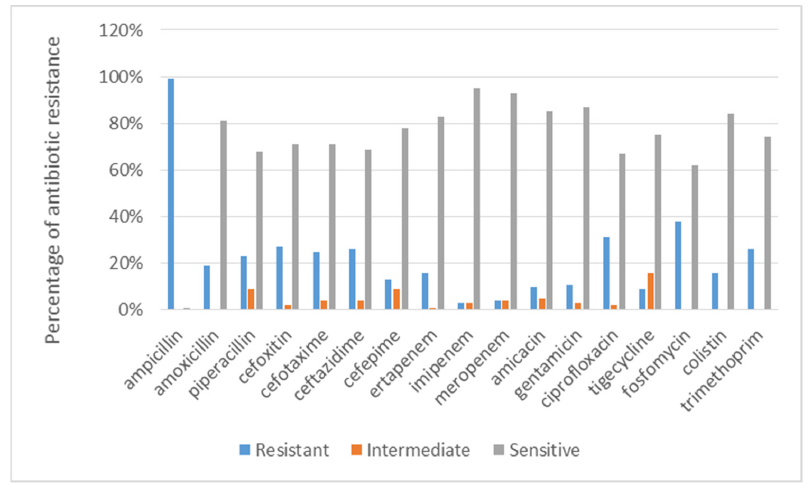
Figure 5. Percentages of antibiotic resistance for external patients in the database described in Sec- tion 2.2.